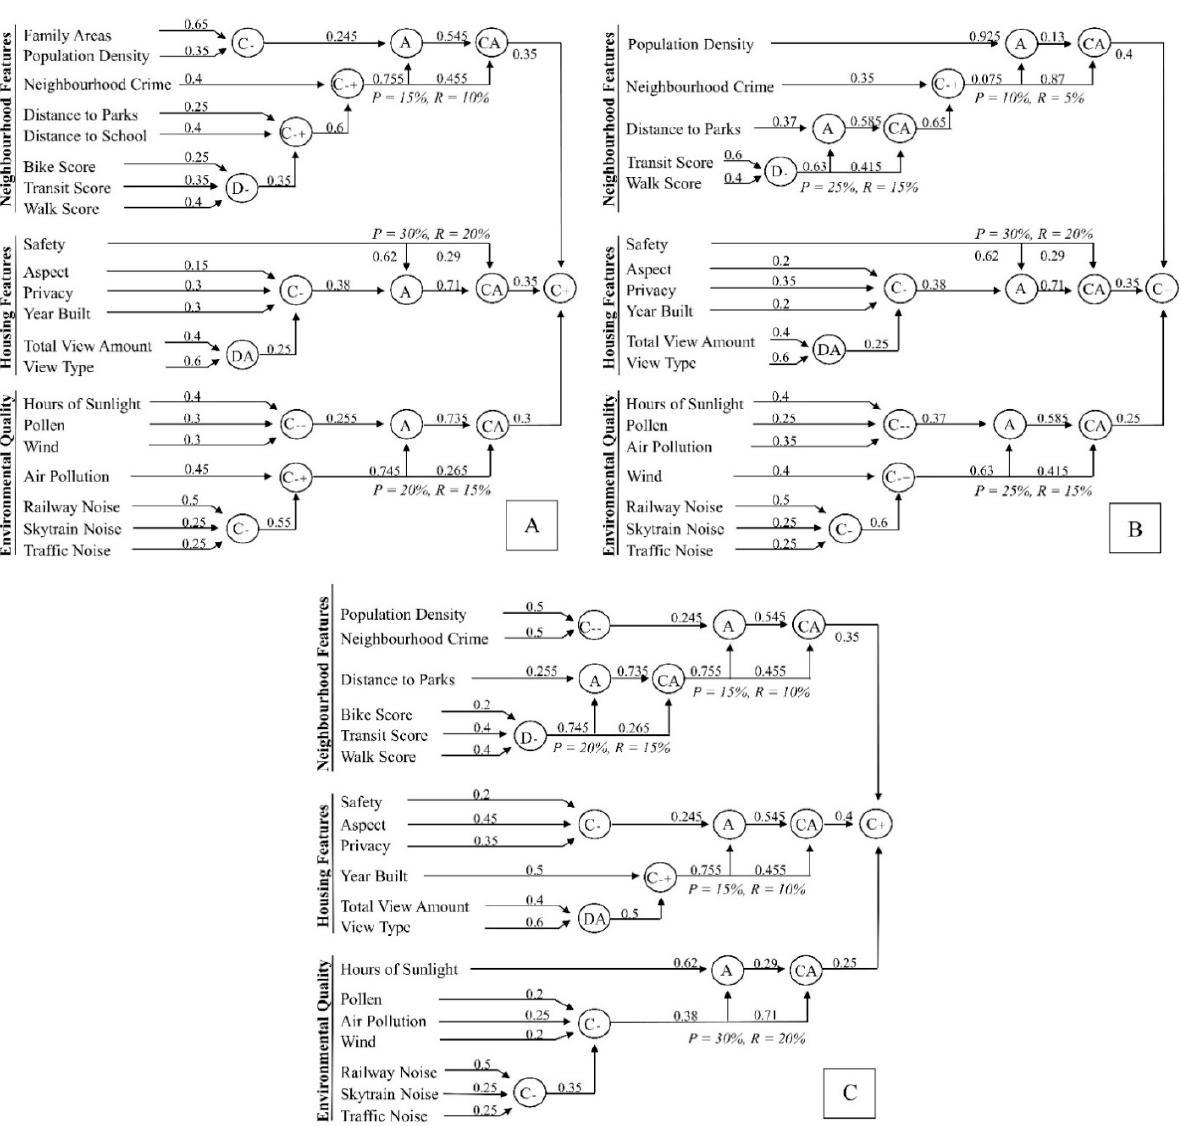
Figure 4. LSP aggregation structures for ( A ) Scenario 1 (family oriented), ( B ) Scenario 2 (elderly oriented), and ( C ) Scenario 3 (working professionals oriented).